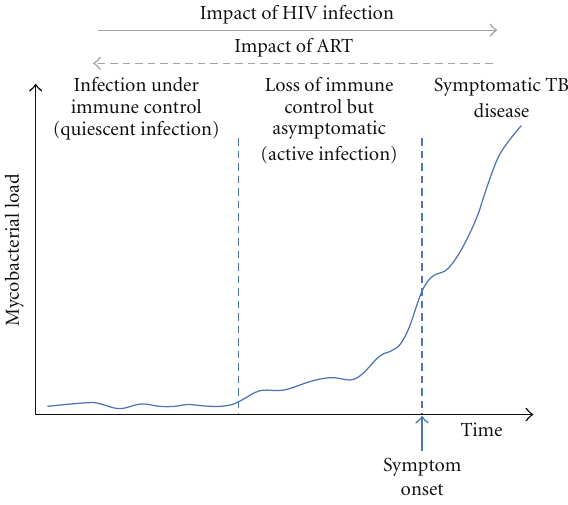
Figure 1: A conceptual stylised diagram showing rising total bacillary load of Mycobacterium tuberculosis over time in an infected patient. The patient initially retains good immune control and low bacillary numbers (quiescent infection). Subsequent loss of immune control is associated with rising bacillary numbers (active infection) and eventual development of symptoms (TB disease). The risk of transition from latent infection to active infection and disease is increased markedly by HIV coinfection whereas antiretroviral therapy would tend to enhance immune